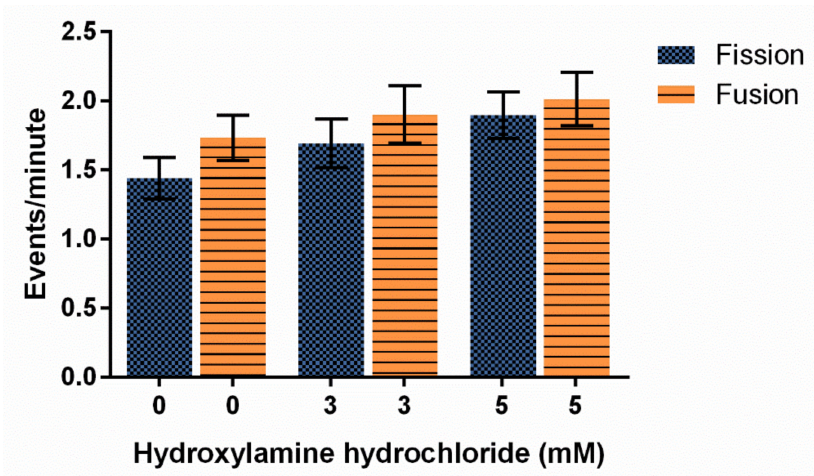
Figure 6. Effect of hydroxylamine hydrochloride on mitochondrial fission and fusion frequency in D. discoideum. Increasing HA does not significantly alter average ± SE fission and fusion events, though these rates trend faster with more HA (n = 34 cells for each treatment, p = 0.2450).